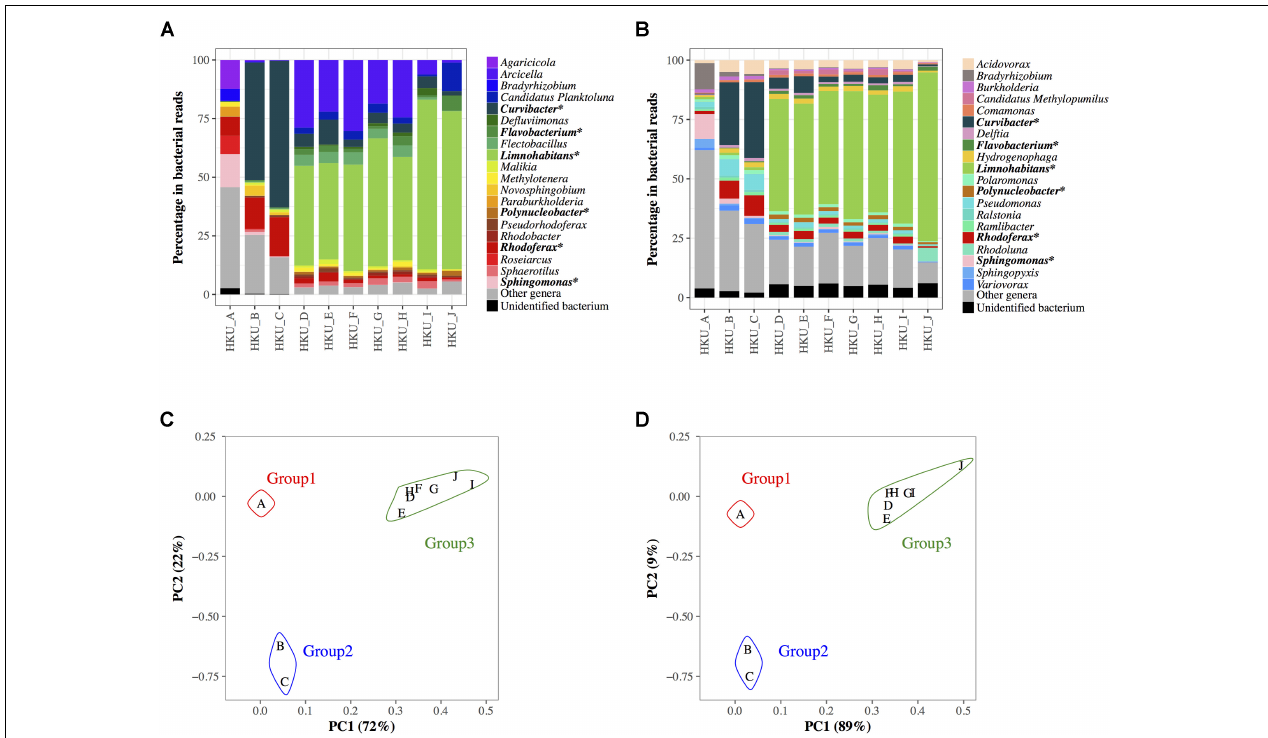
FIGURE 3 | Bacterial communities at genus level in water samples determined by the lowest common ancestor algorithm in MEGAN. (A) Bacterial communities based on the results of a blastn search of 16S rRNA amplicon reads against nucleotide sequences from the NCBI-16SMicrobial-NT database. (B) Bacterial communities based on the results of the blastn search of shotgun sequencing reads against nucleotide sequences from the NCBI-NT database. Colored bars represent the top 20 abundant genera in all samples. Reads from other minor genera are represented in gray, and the reads with unidentified genera are represented in black. The genera ranked in top 20 in both 16S rRNA amplicon and shotgun metagenomic analyses are indicated with asterisks. The results of principal component analysis of the bacterial communities using 16S rRNA reads and shotgun reads are shown in (C,D) , respectively. TABLE 2 | Number of shotgun reads identified as Legionella pneumophila by MEGAN, Kraken, CLARK, VFDB, and mip gene. Samples Nested PCR targeting the mip gene